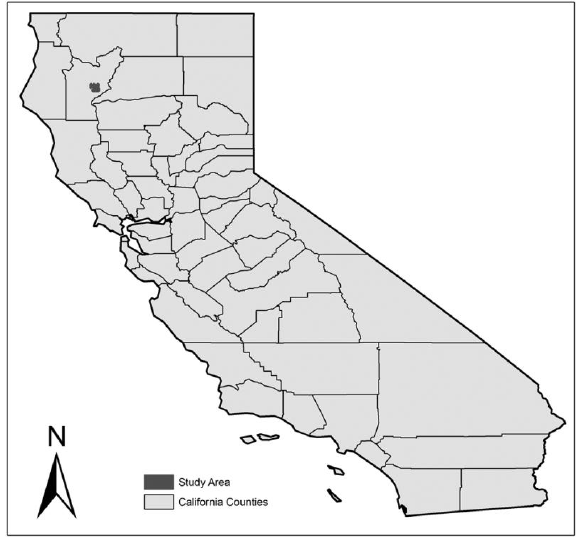
Figure 1. Forest study area in Trinity County, California, CA, USA.